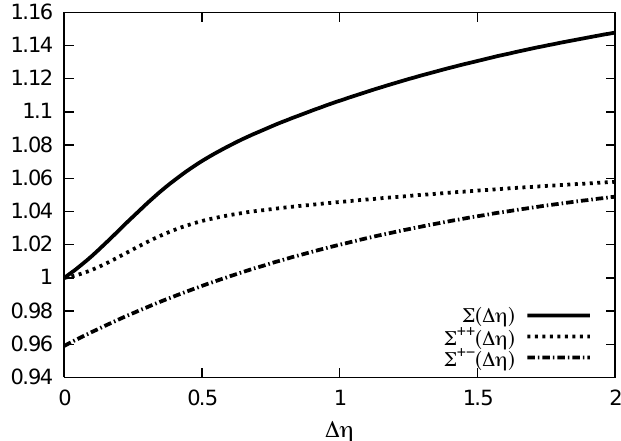
) ≡ Σ ++ ( ∆ η ) (dotted line) and , n + F B